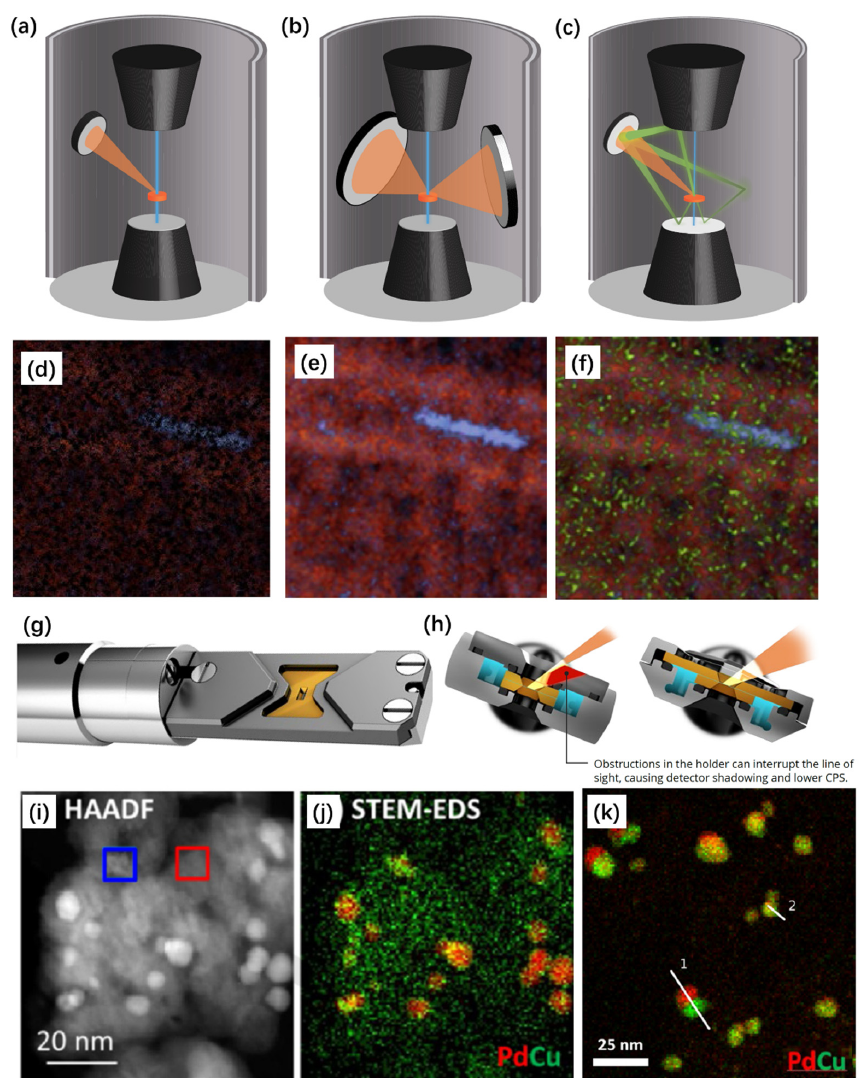
Figure 5. Techniques for improving x-ray dispersive spectroscopy (EDS) detection. ( a – c ) Schematic of EDS detector ( a ) EDS detector ( b ) EDS detectors with larger collection angles or multiple detectors. ( c ) EDS detectors that collecting both characteristic and non-characteristic